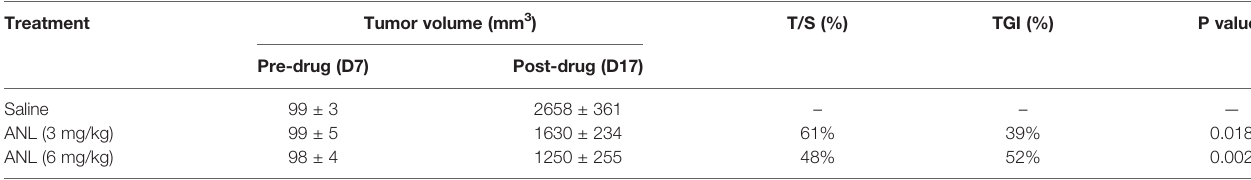
TABLE 1 | Overview of tumor growth inhibition in vivo in Renca syngeneic model in mice.